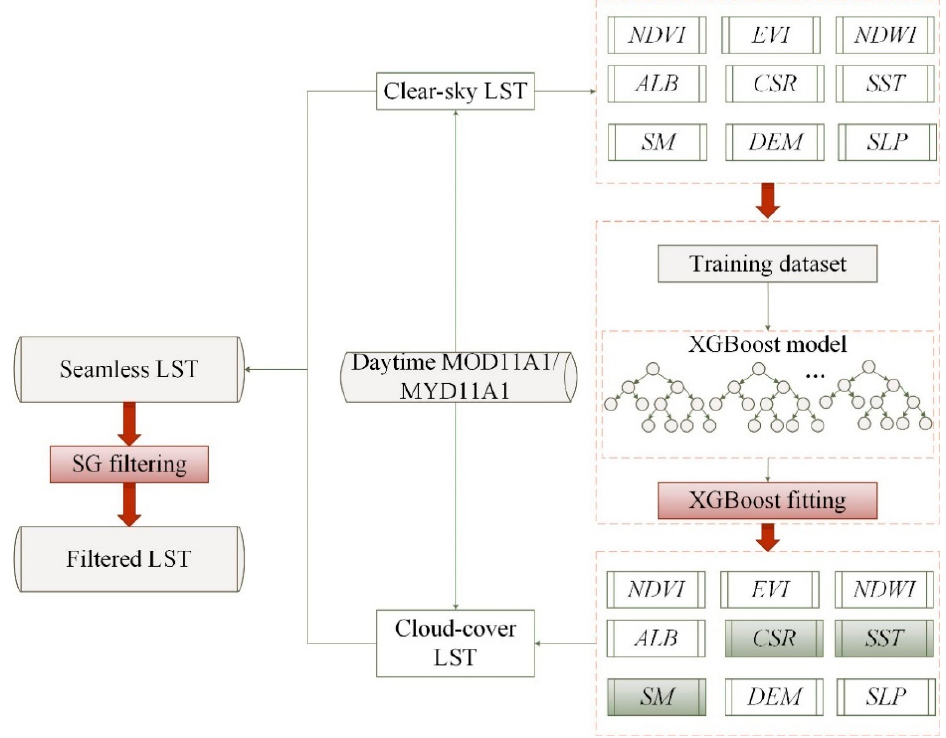
Figure 2. The scheme of the daytime LST reconstruction process. Three instantaneous variables are shaded in green.